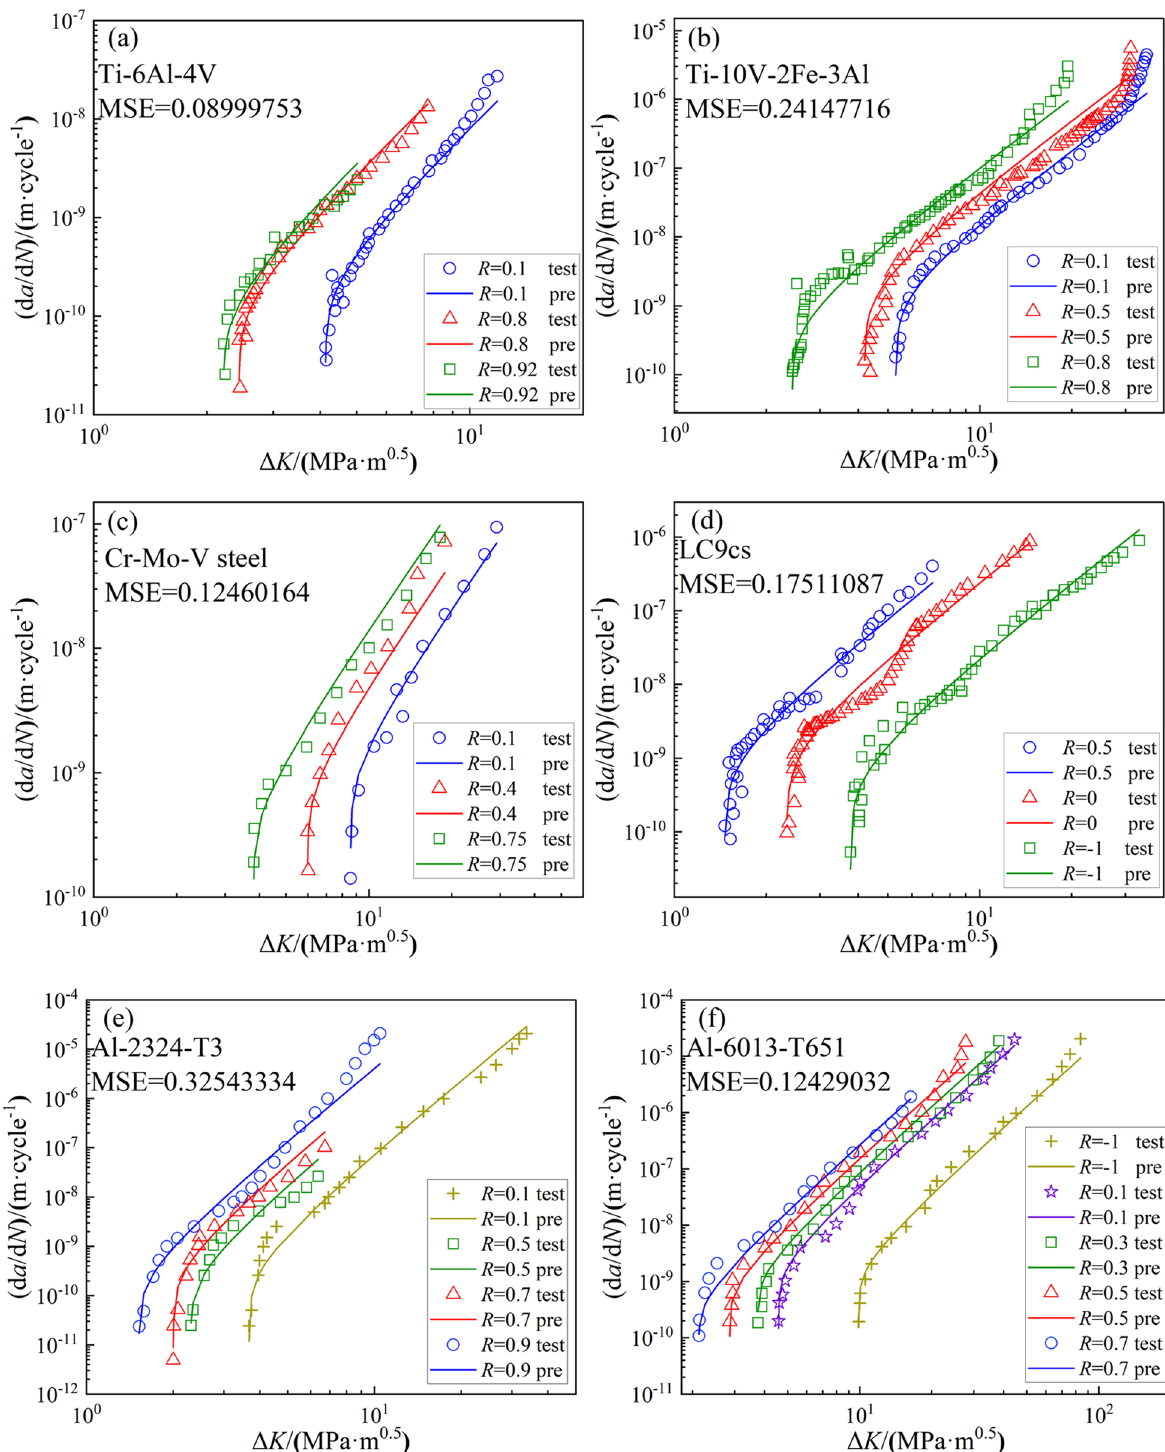
Figure 8 SR model predicting curves and test data about six materials: a Ti-6Al-4V, b Ti-10V-2Fe-3Al, c Cr-Mo-V steel, d LC9cs, e Al-2324-T3,